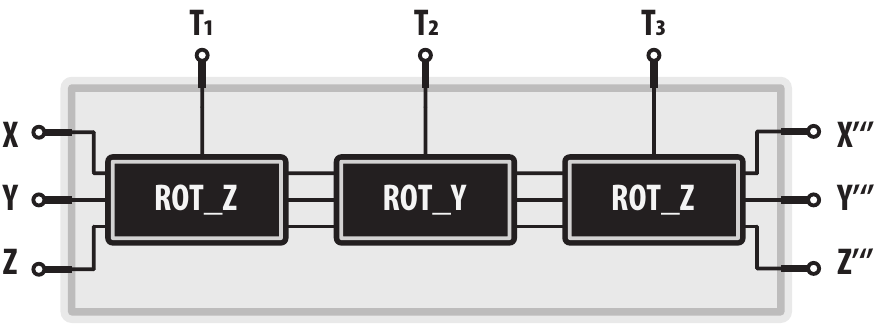
Figure 12. Orientation module for the gimbal mechanism.